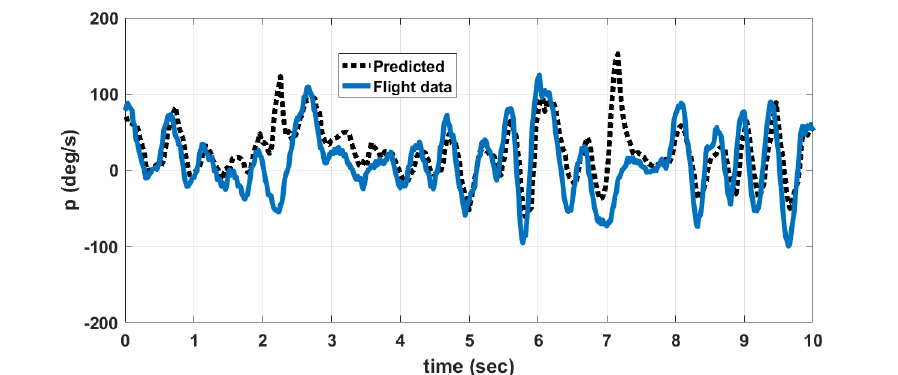
Figure 16. Comparison of angular rate p , predicted by model and flight data.